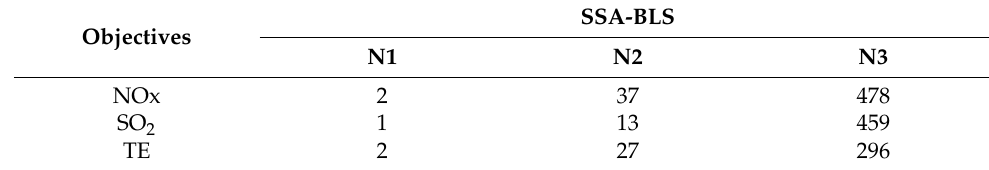
Table 8. The hyper-parameters of SSA-BLS and BLS for boiler data modeling.